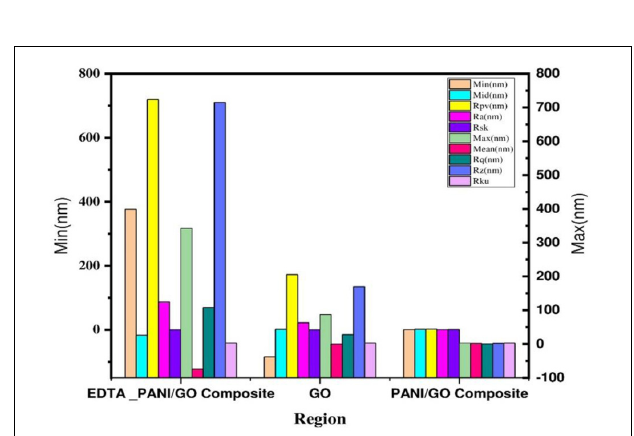
FIGURE 6 | Comparative atomic force microscope (AFM) images with respective line profiles of (A) GO, (B) PANI/GO composite, and (C) EDTA modified PANI/GO composite.